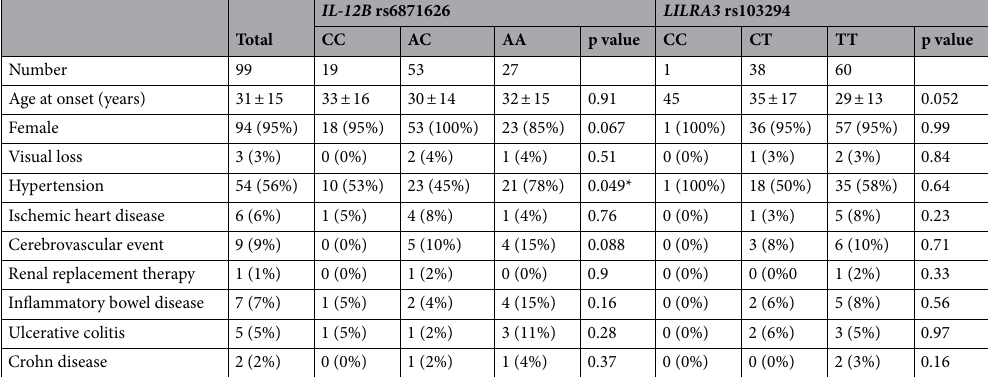
Table 1. Backgrounds and organ involvements of the subjects. Data are n (%) or mean ± standard